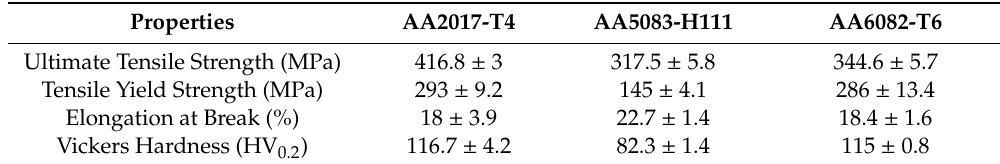
Table 2. Mechanical properties of the tested aluminum